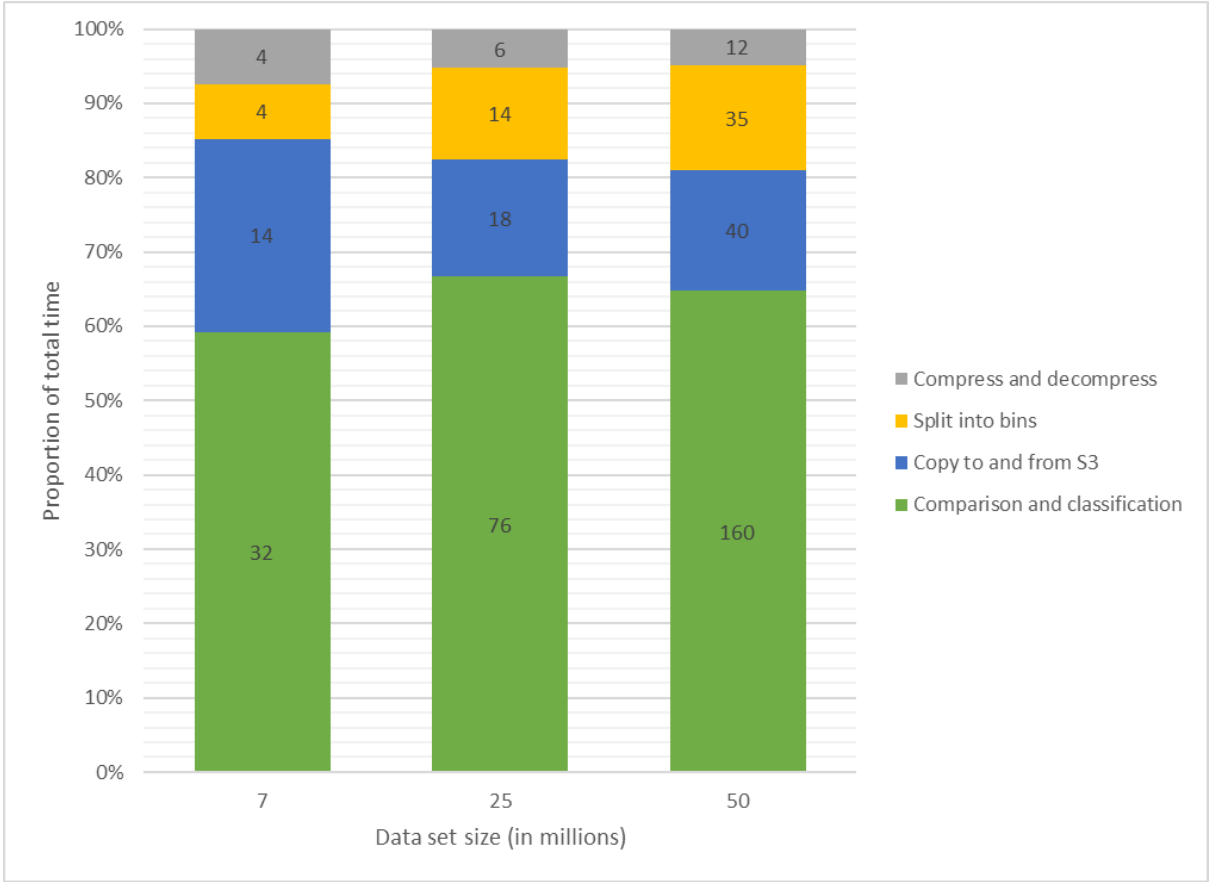
Figure 9. Task execution time (in minutes) and the proportion of total